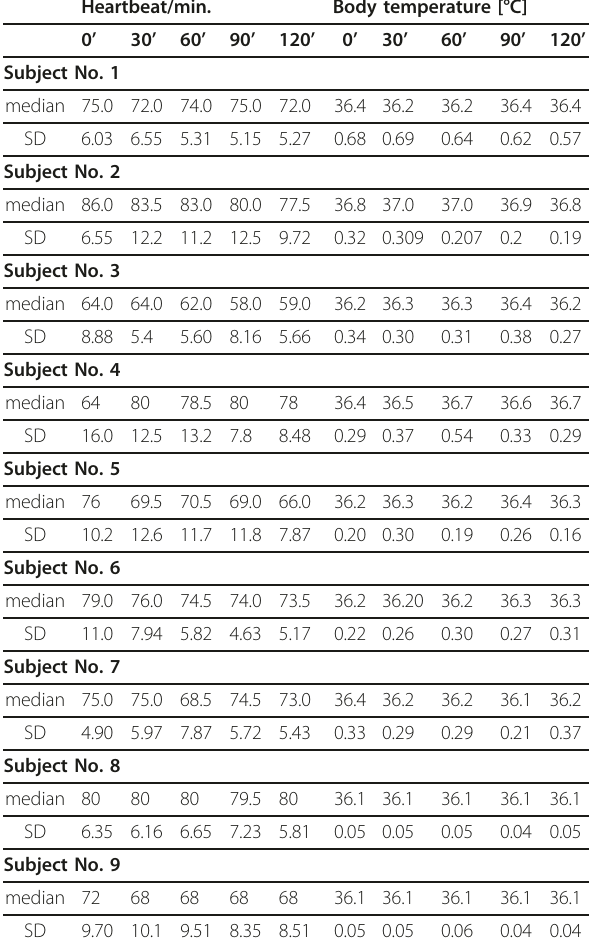
Table 3 Vital signs after autologous E.coli autovaccine application